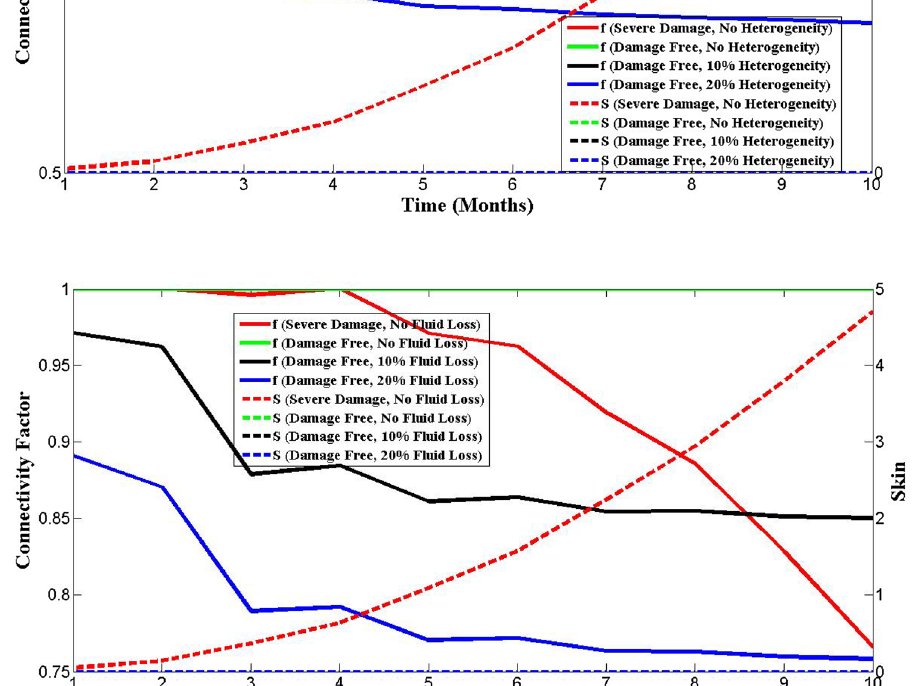
Fig. 12 Connectivity factor and skin versus time for the different fluid